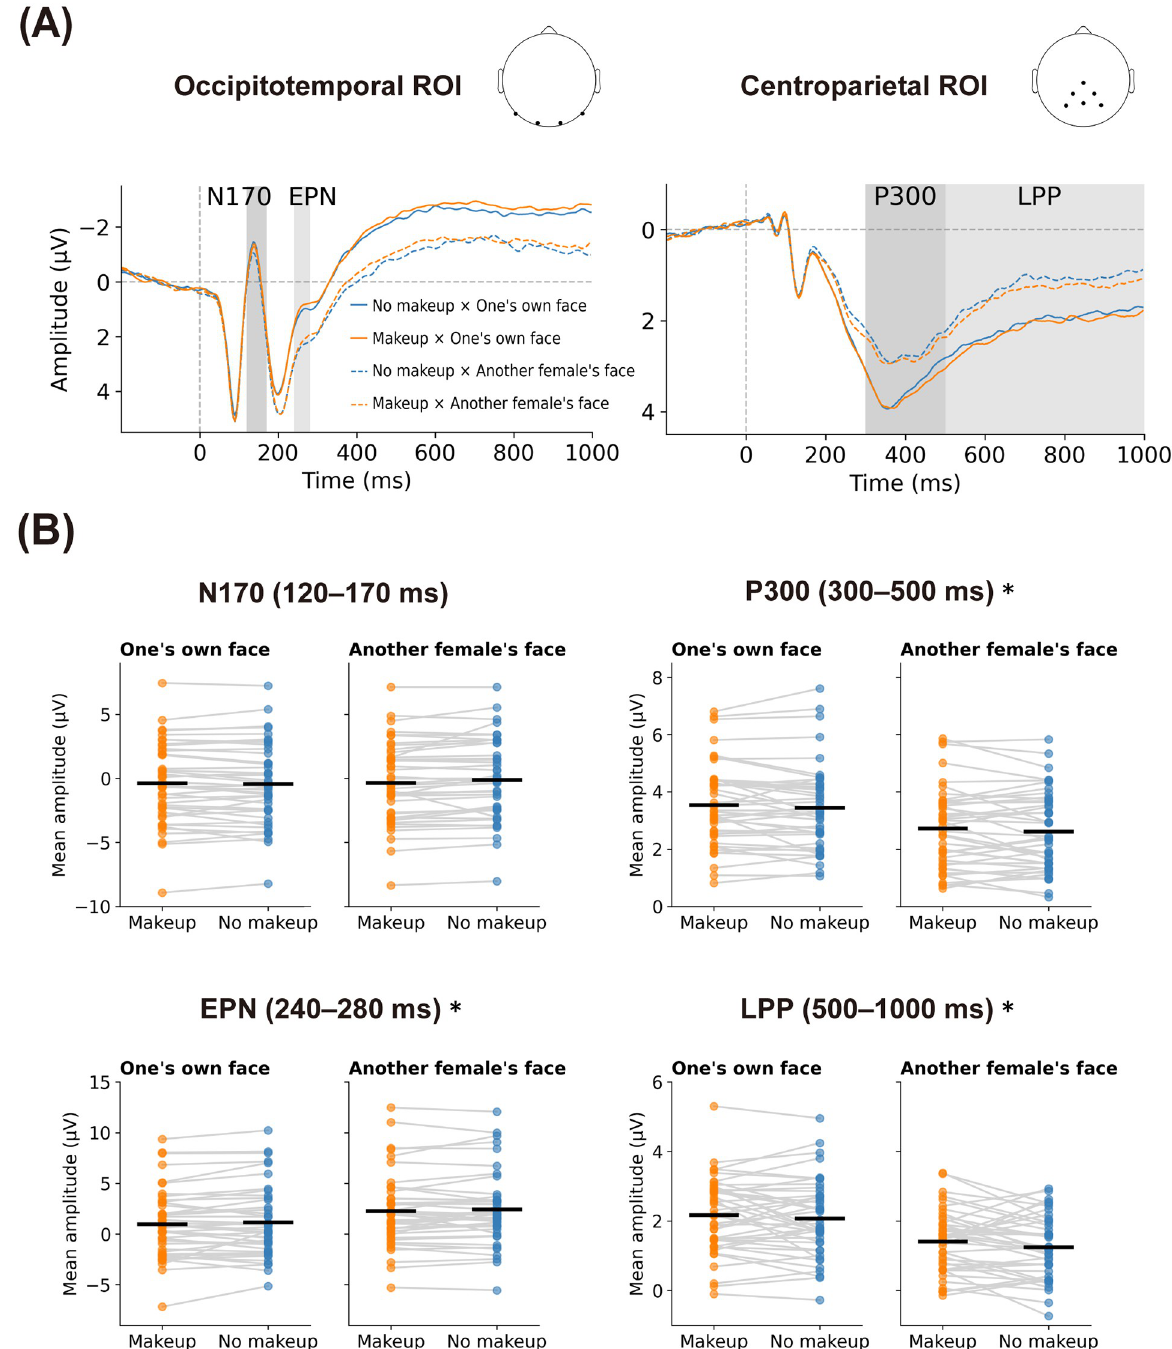
Fig 4. ERP results in Experiment 2. Panel A shows the grand average ERP waveforms elicited by facial images in the occipitotemporal and centroparietal ROIs. Panel B shows repeated measures plots visualizing amplitudes of the N170, EPN, P300, and LPP components across the makeup conditions (makeup vs. no makeup), aggregated either by one’s own face (left panel) or by another female’s face (right panel). Horizontal black lines represent the mean amplitudes for each condition. Asterisks indicate a significant main effect of makeup pooled across face images of different identities determined by a within-subject two-way ANOVA ( p < 0.05). ERP, event-related potential; ROI, region of interest; EPN, early posterior negativity; LPP, late positive potential; ANOVA, analysis of variance.